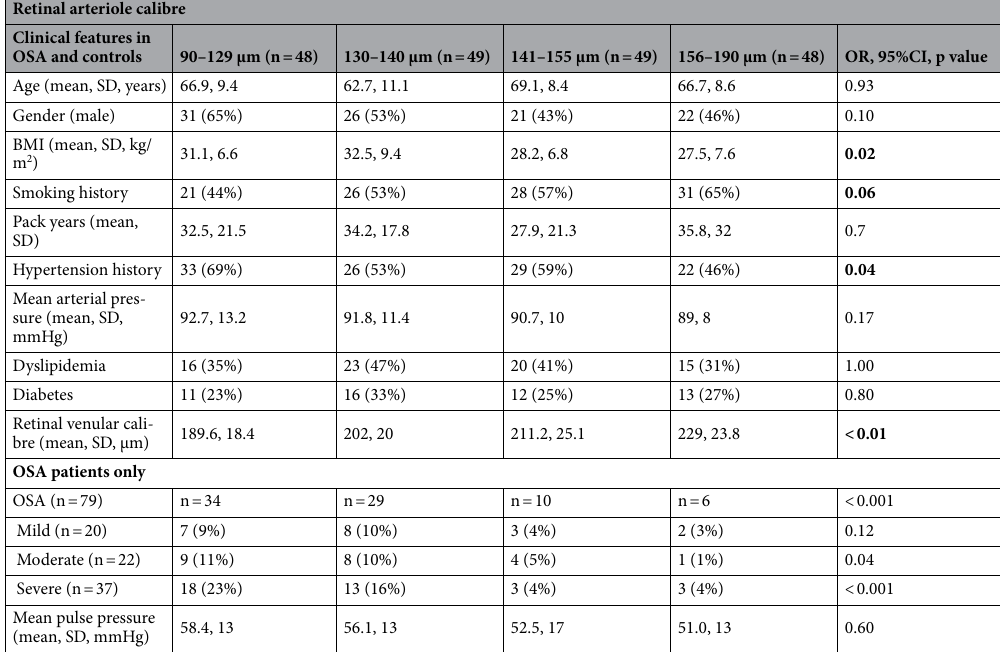
Table 3. Clinical features and retinal arteriole calibre in OSA plus hospital controls by quartile. Smaller retinal arteriole calibre was associated with a higher BMI (p = 0.02), a hypertension diagnosis (p = 0.04) and a smaller venular calibre (p < 0.01), and there was a trend with less smoking history (p = 0.06). In the patients with OSA, all OSA was associated with a smaller arteriole calibre (p < 0.001). Moderate and severe OSA were associated with a smaller arteriole calibre (p = 0.04, p < 0.001 respectively). Retinal arteriole calibre was not associated with mean pulse pressure (p = 0.60). Significant values are in bold.